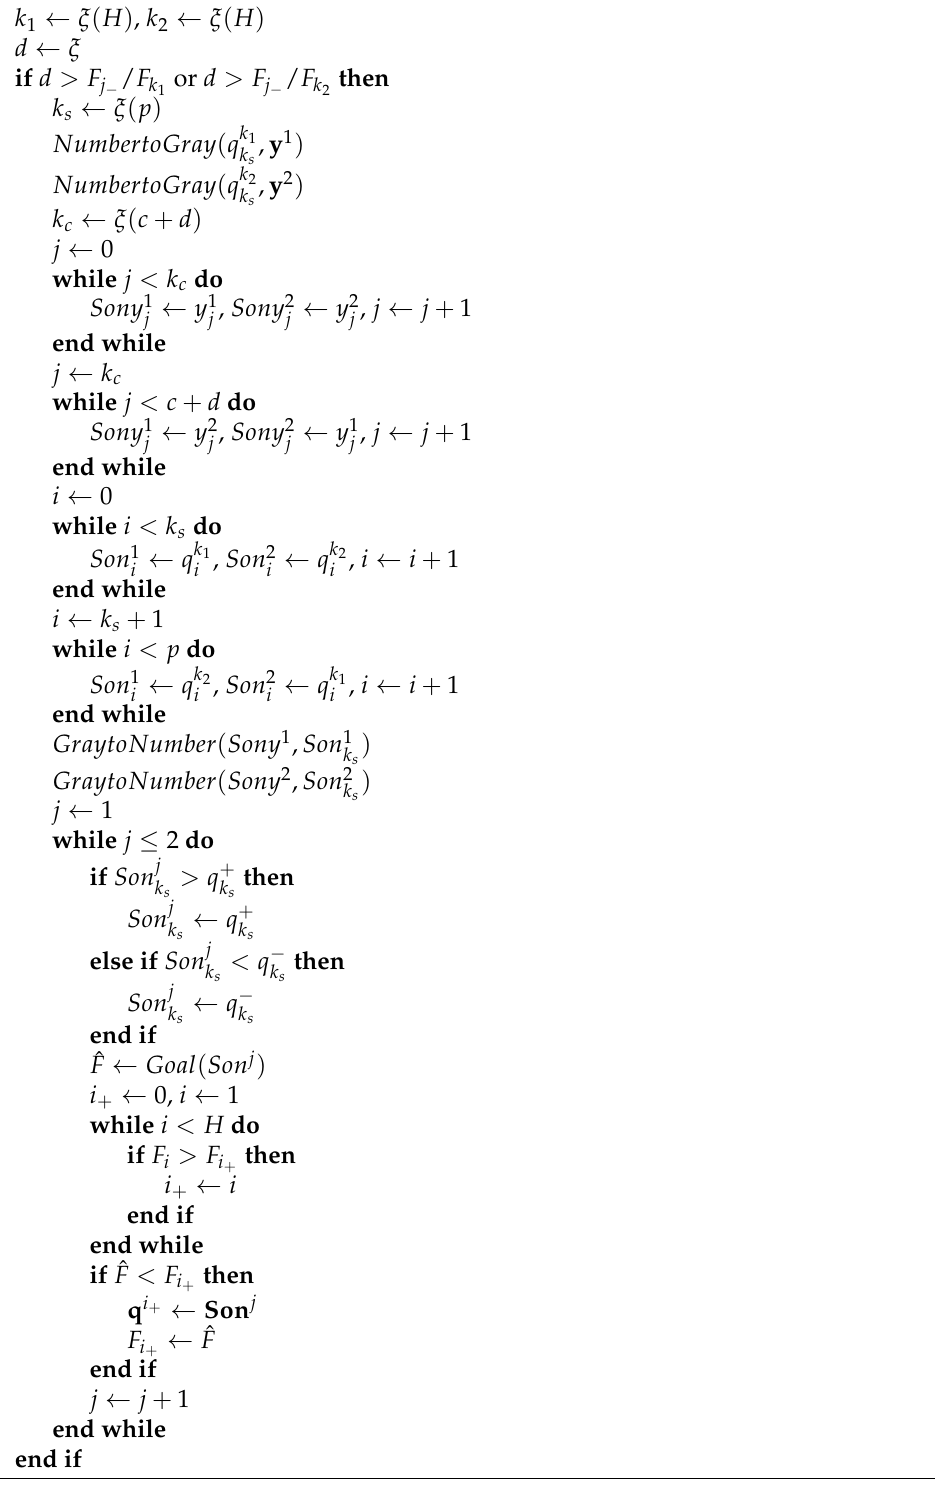
Algorithm A3 GA